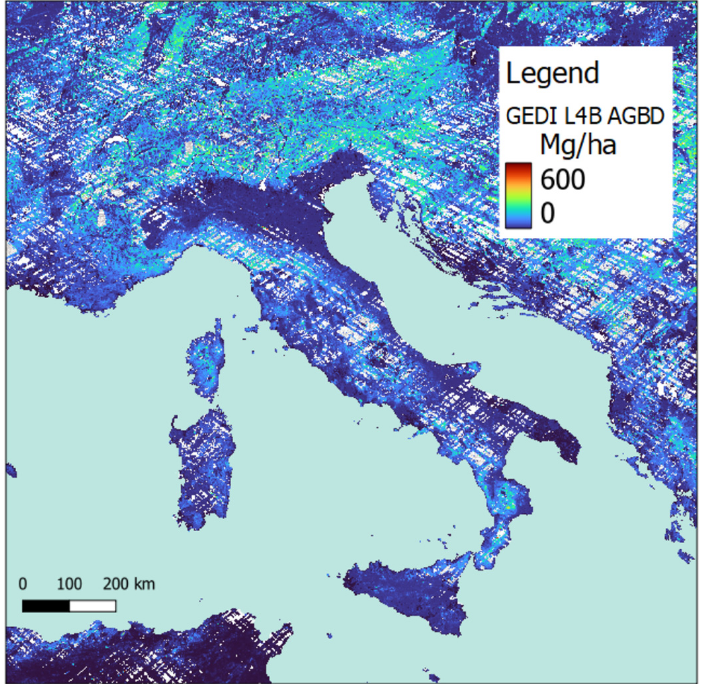
Figure 2. GEDI L4B product reporting the mean aboveground biomass density